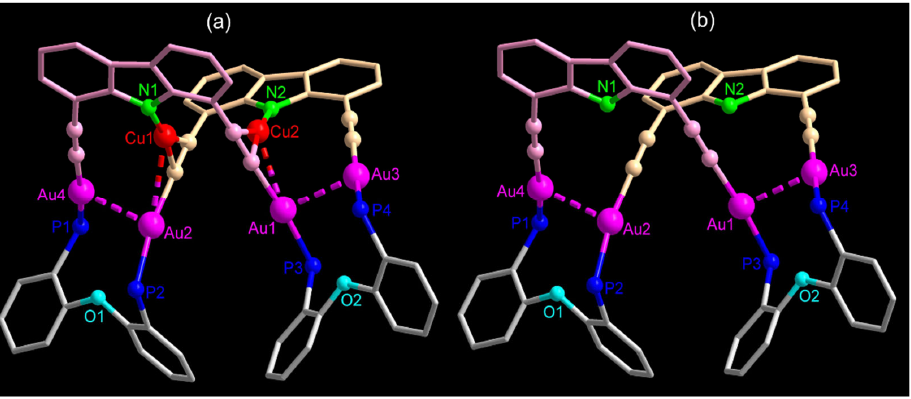
Figure 1. ( a ) A view of the Au 4 Cu 2 cluster complex. The hydrogen atoms and tert -butyl groups, together with the phenyl rings on phosphorous atoms, were omitted for clarity. ( b ) A view showing a scissor-like structure of the Au 4 (decz) 2 (POP) 2 framework formed by gold(I)–bis(acetylide) σ -coordination.